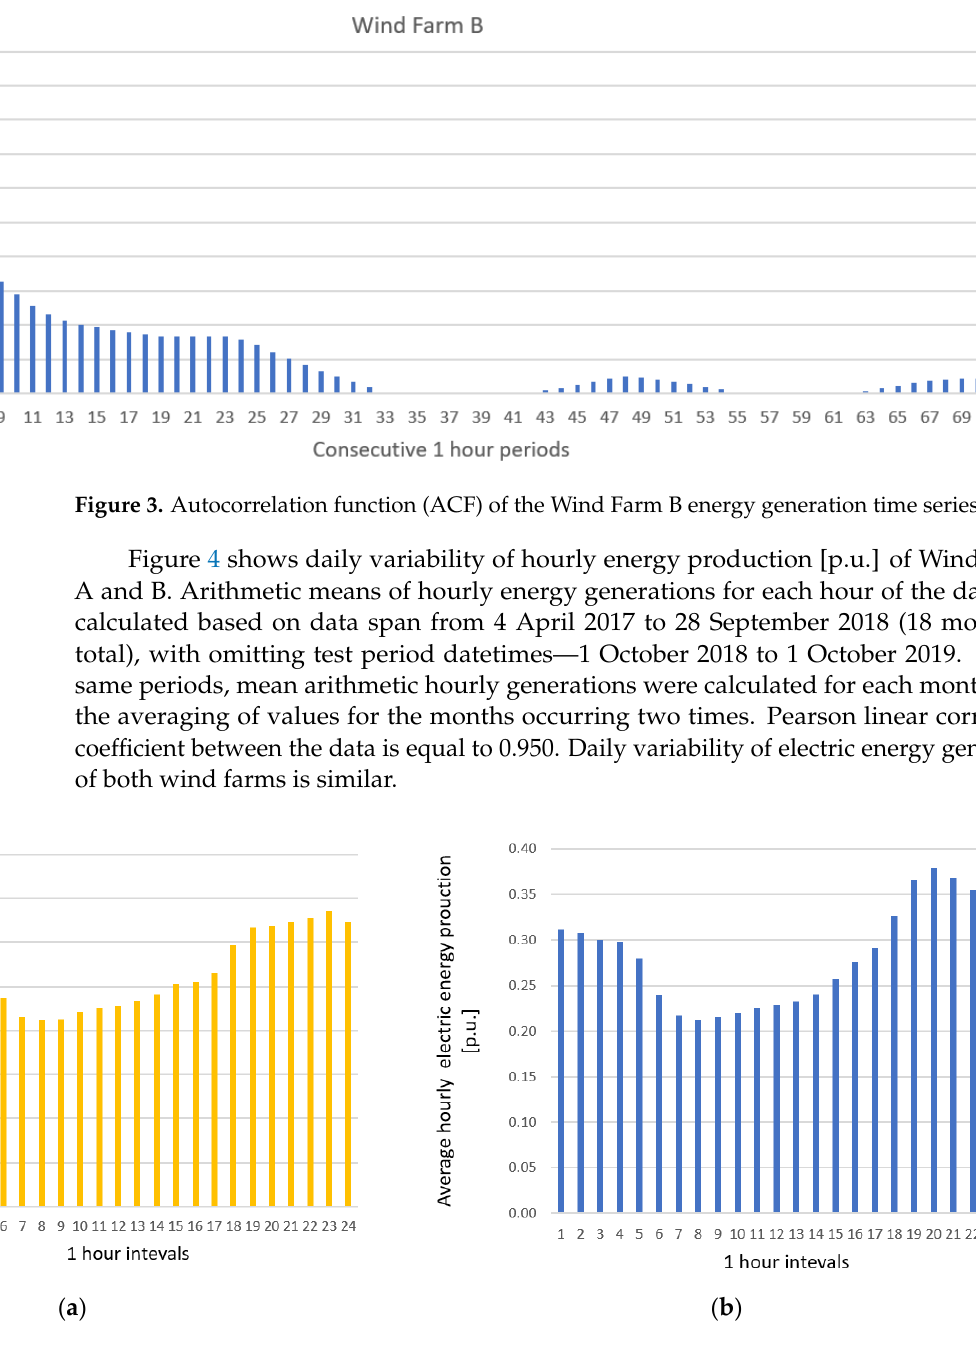
Figure 2. Autocorrelation function (ACF) of the Wind Farm A energy generation time series.